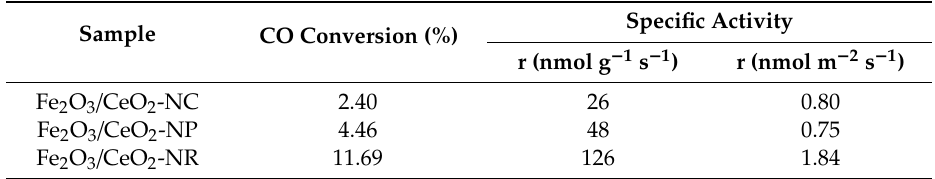
Table 5. CO conversion and specific activity of Fe 2 O 3 / CeO 2 samples at 125 ◦ C. Reaction